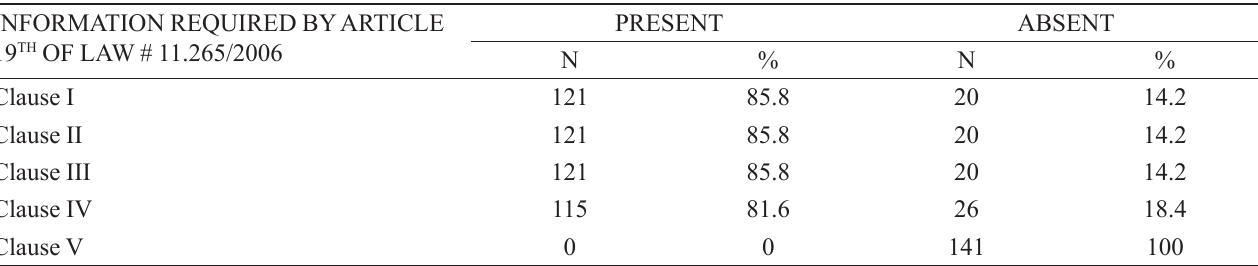
TABLE I – Evaluation of advertisements collected in technical-scientific and educative materials, in the period of 2006 June to 2008 May, in the city of Natal/RN INFORMATION REQUIRED BY